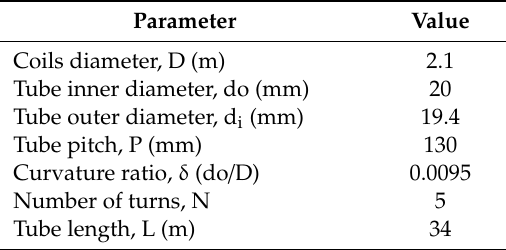
Figure 2. ( a ) Position of 24 test points on model 3D. ( b ) Diagram dimension of the 24 test points [15]. Table 1. Geometry dimension of the HCT [15].